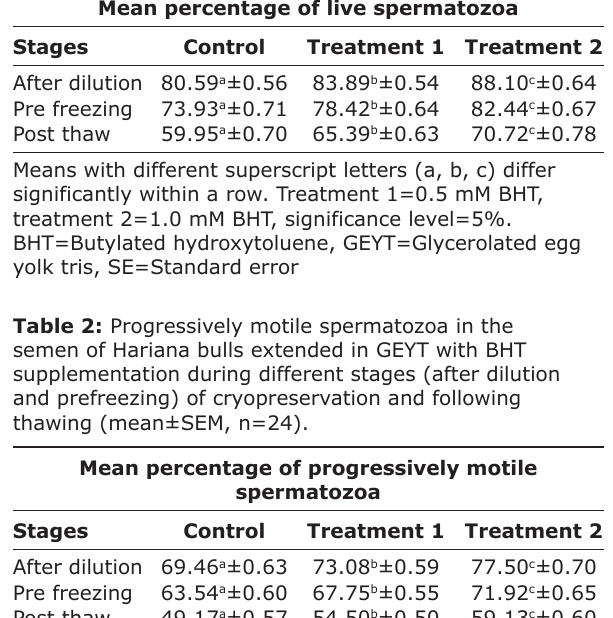
Table-1: Live spermatozoa in the semen of Hariana bulls extended in GEYT with BHT supplementation during different stages (after dilution and prefreezing) of cryopreservation and following thawing (mean±SE, n=24).